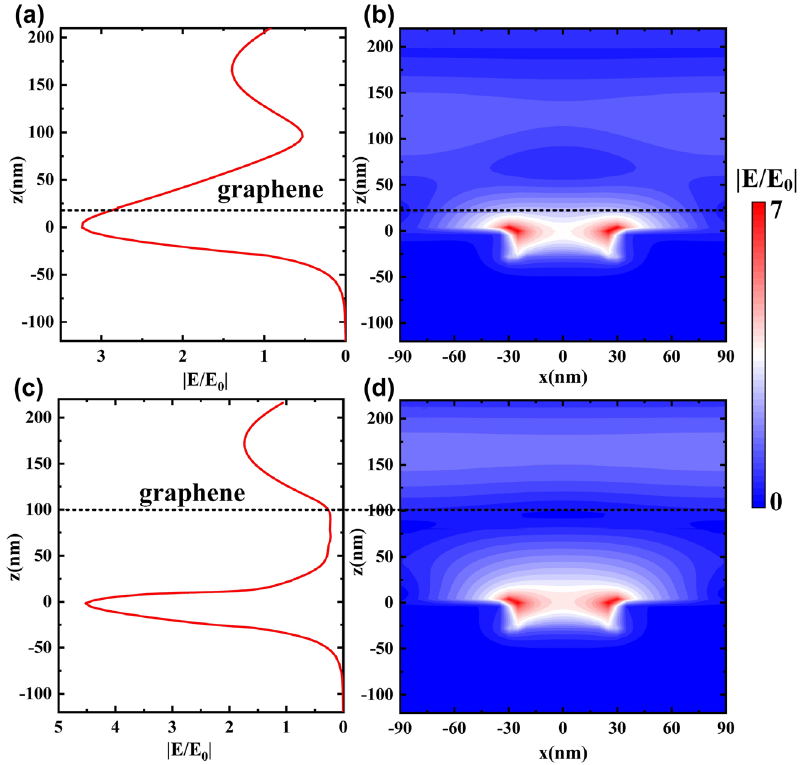
Figure 3: Dependence of the electric field distribution on the space between the graphene and the metamaterial substrate, where 𝜆 = 300 nm is used. (a) With space of z = 20 nm. (b) With space of z = 100 nm. The dotted line shows where the graphene is in